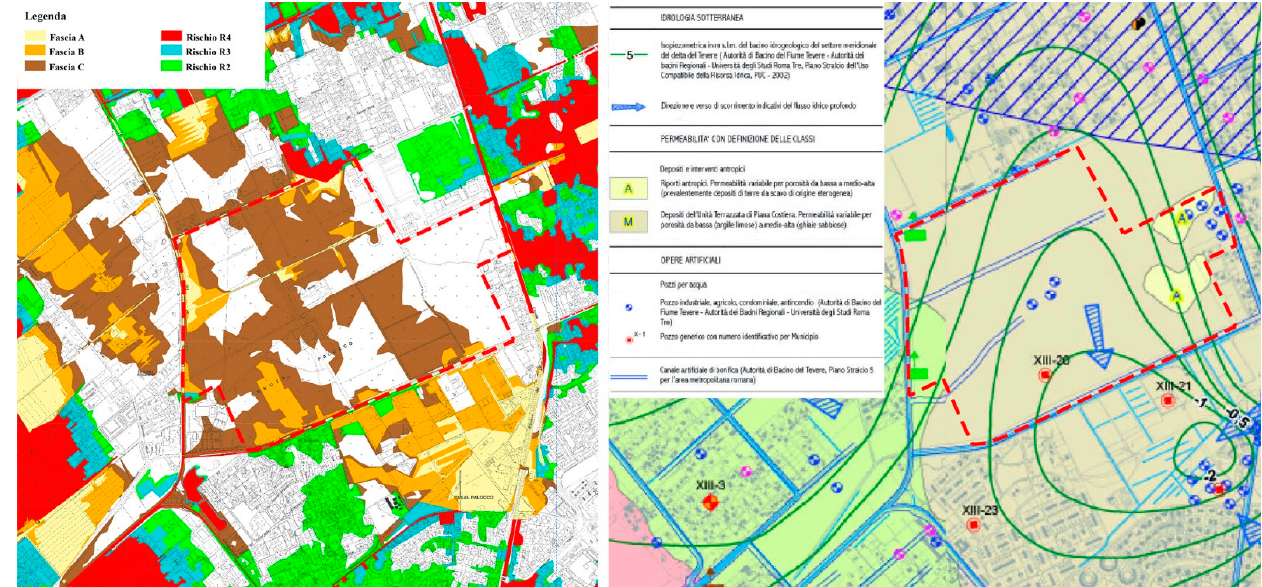
Figure 3. Left, PAI Tiber. Tavv PB 88 I, II, III Bands and hydraulic risk on the secondary and minor